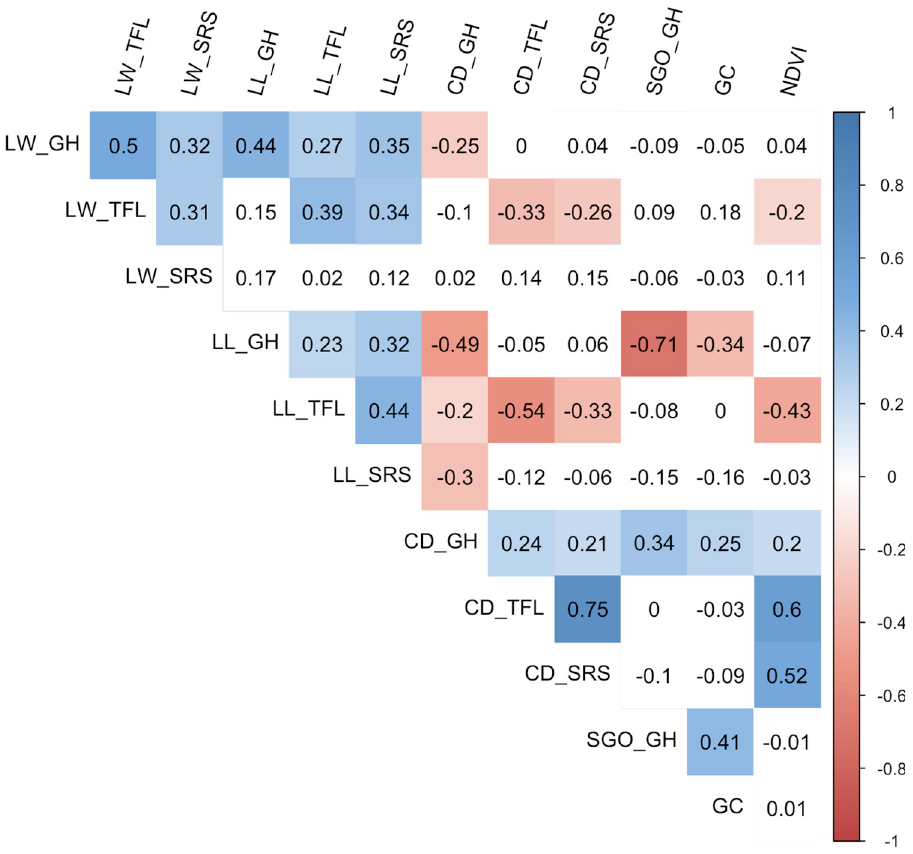
Fig 2. Correlation of morphological and drought traits for a St. Augustinegrass Raleigh x Seville F 1 population evaluated in greenhouse (GH) and field (TFL and SRS). Morphological traits include leaf width (LW), leaf length (LL), canopy density (CD) and shoot growth orientation (SGO), while drought traits include percent green cover (GC) and normalized difference vegetation index (NDVI) reported in Yu et al. (2019) [10]. Blue color indicates positive correlation, while red color indicates negative correlation, with more intense colors for more extreme correlations. Correlations not significantly different from 0 are represented by a white box.